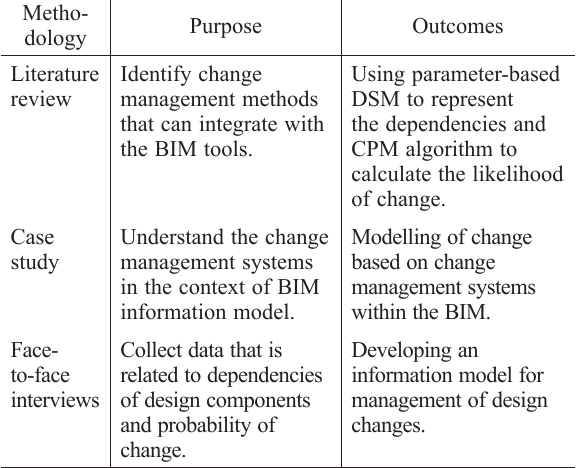
Table 1. Research framework of this study